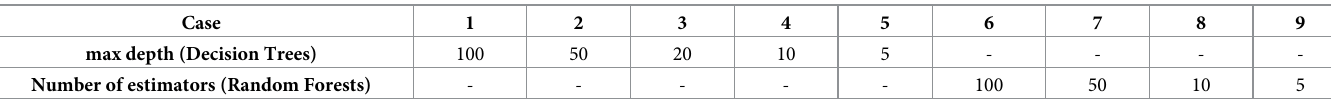
5 Evaluations on machine learning methods Based on the above parametric studies, the results using the six machine learning algorithms with the corresponding optimal parameters in Table 5 were compared with each other. They were systematically evaluated from four aspects: prediction accuracy, computational time, fea- ture sensitivity, and robustness on the failure of some hole port. Table 4. Cases at different parameter